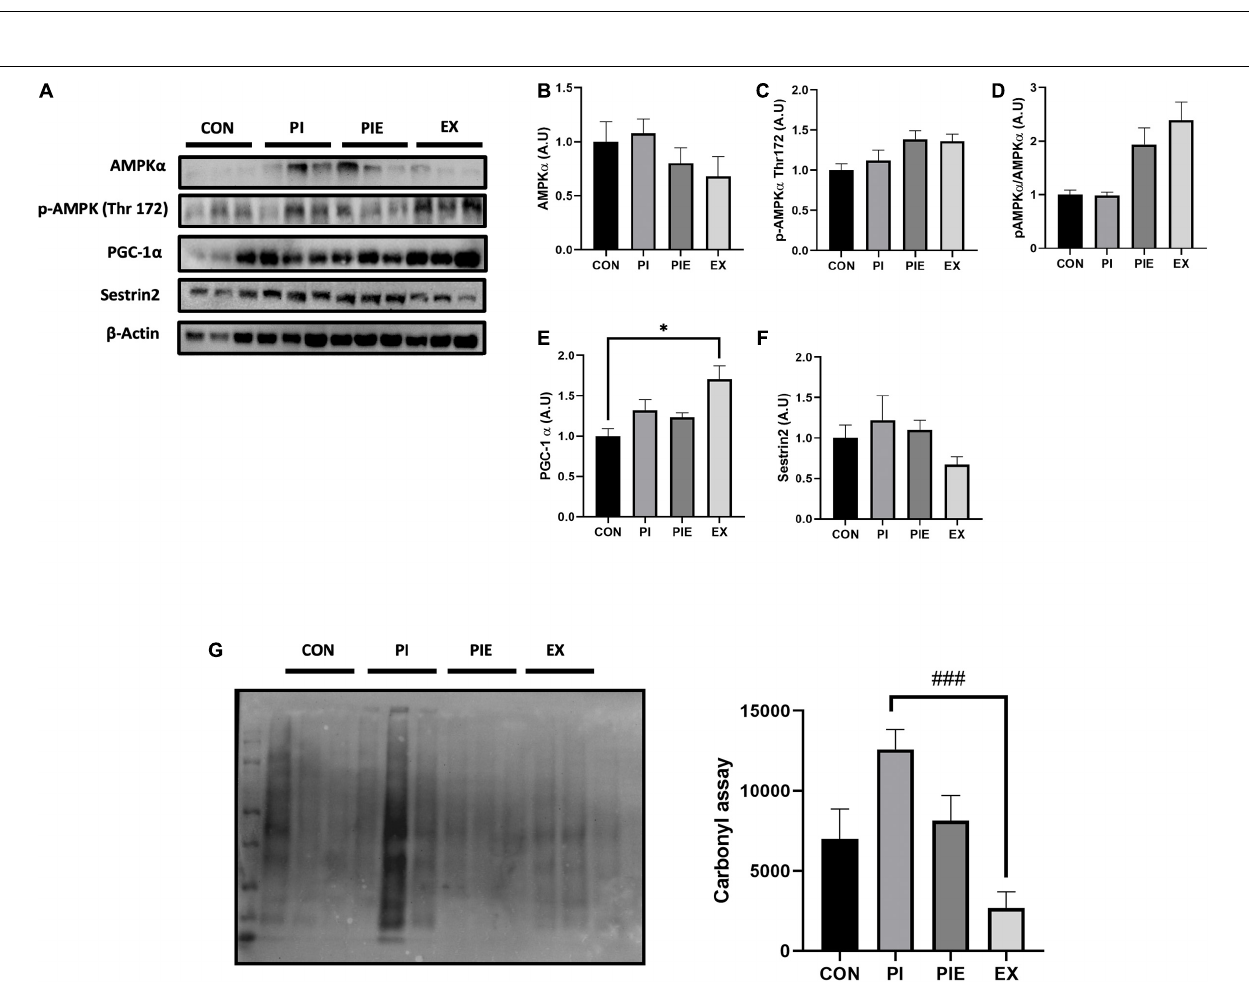
FIGURE 6 | Exercise ameliorated PM-induced oxidative stress in the mouse lungs. (A) Representative western blot images of AMPK α , p-APMK α Thr 172, PGC-1 α , and Sestrin2. Quantification of western blot analysis was performed to access the effect of PM exposure and exercise on AMPK α (B) , p-APMK α Thr 172 (C) , p-AMPK α Thr 172/AMPK α ratio (D) , PGC-1 α (E) , Sestrin2 (F) . Carbonyl assay (G) and it’s quantification. Values are the means ± SEM ( n = 6). ∗ P < 0.05 vs. CON, ### P < 0.001 vs. PI.